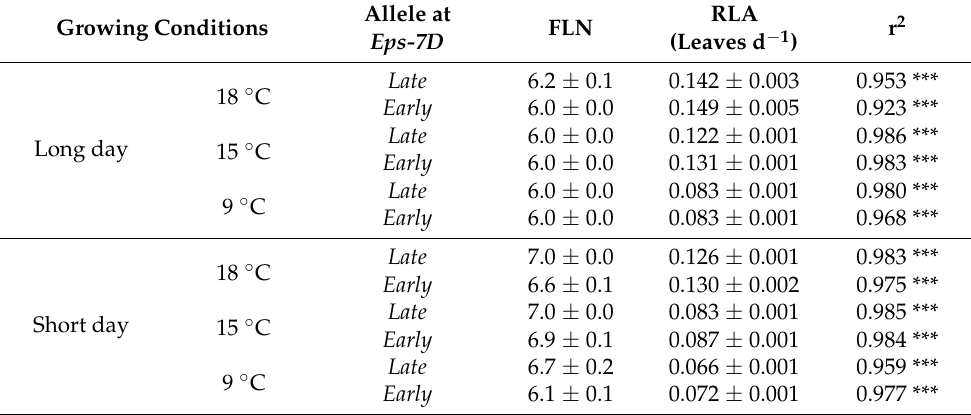
Table 1. Effects of the Eps-7D gene on final leaf number (FLN), rate of leaf appearance (RLA; estimated as the slope of the linear regression of leaf number vs. thermal time), and the coefficient of determination for that regression (r 2 ), when grown under two contrasting photoperiods (12 and 24 h) and three temperatures. RLA Allele at FLN Growing Conditions r 2 Eps-7D (Leaves d − 1 ) Late 6.2 ± 0.1 0.142 ± 0.003 0.953 *** 18 ◦ C Early 6.0 ± 0.0 0.149 ± 0.005 0.923 *** Late 6.0 ± 0.0 0.122 ± 0.001 0.986 *** Long day 15 ◦ C Early 6.0 ± 0.0 0.131 ± 0.001 0.983 *** 6.0 ± 0.0 0.083 ± 0.001 Early 6.0 ± 0.0 0.083 ± 0.001 0.968 *** Late 7.0 ± 0.0 0.126 ± 0.001 0.983 *** 18 ◦ C Early 6.6 ± 0.1 0.130 ± 0.002 0.975 *** Late 7.0 ± 0.0 0.083 ± 0.001 Short day 15 ◦ C 6.9 ± 0.1 0.072 ± 0.001 0.977